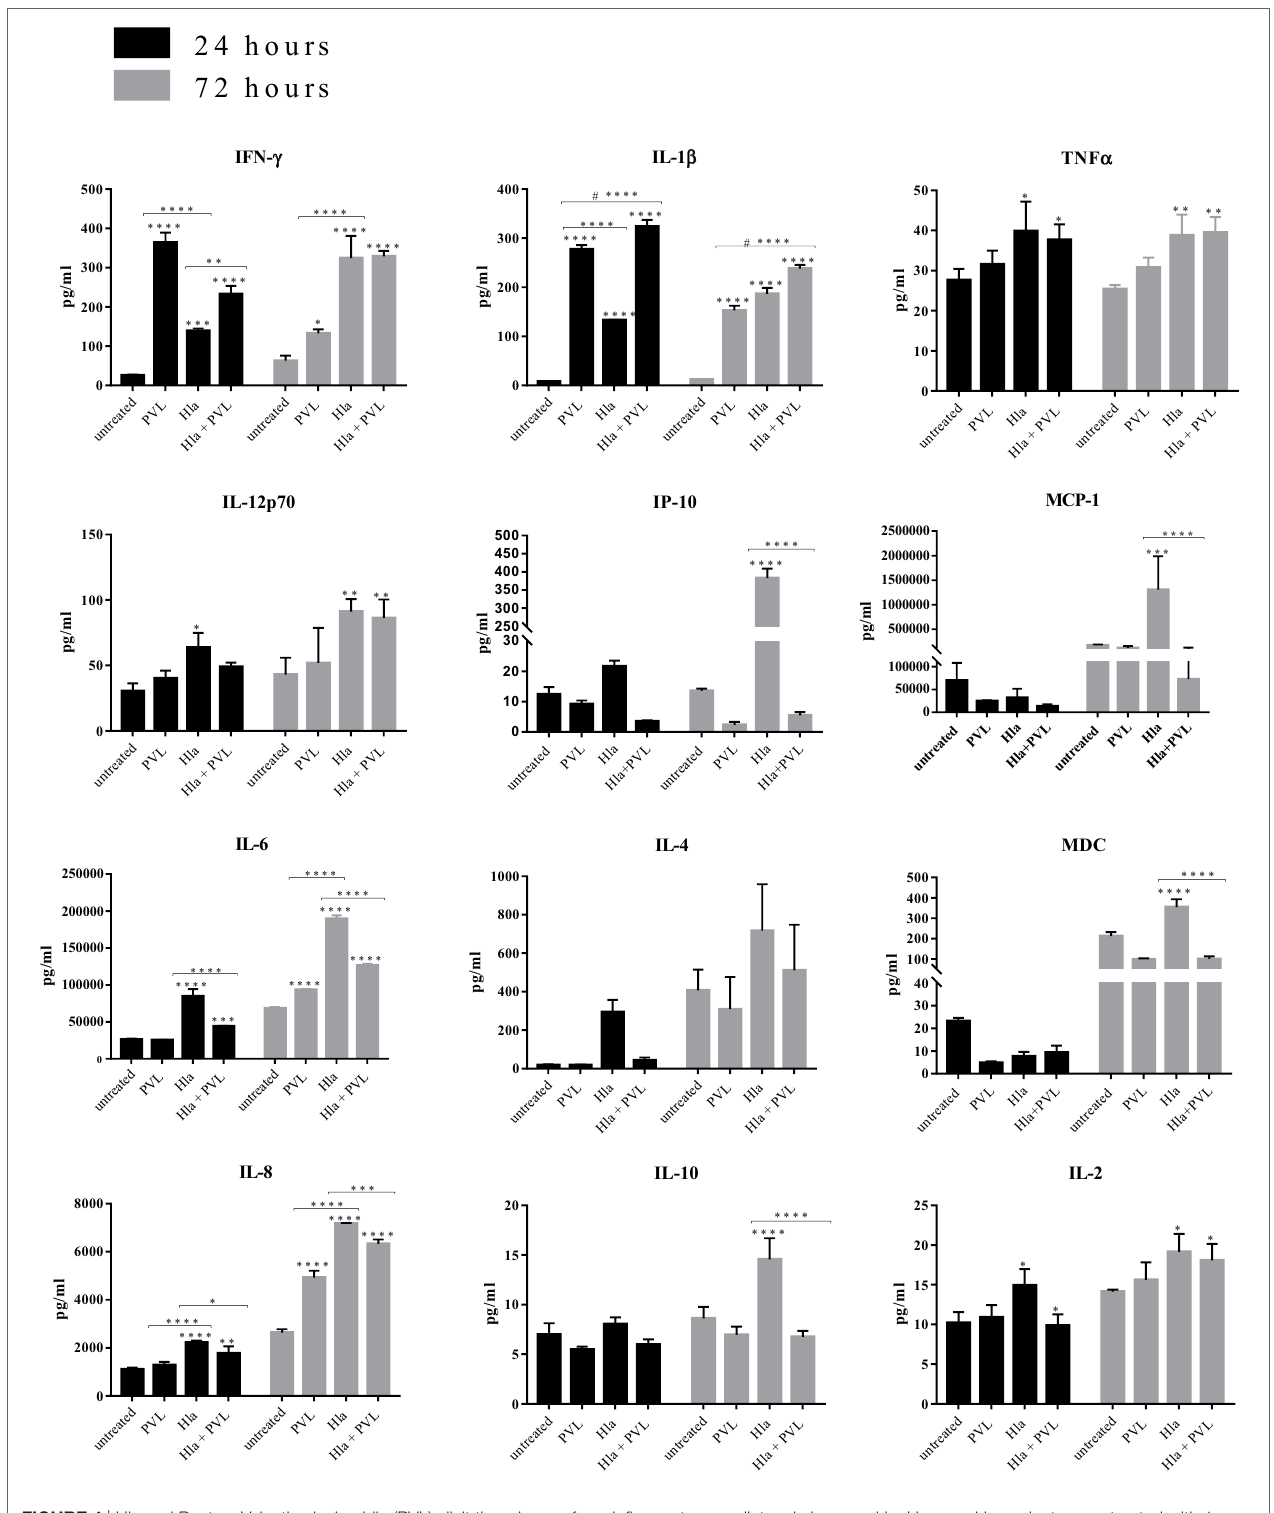
FigUre 4 | Hla and Panton–Valentine leukocidin (PVL) elicit the release of pro-inflammatory mediators in human skin. Human skin explants were treated with 1 µg of Hla, PVL, or a cocktail of both toxins at 1 µg each. Each bar represents the mean ± SD of three analyses from the skin of one donor. In addition, results were confirmed using skin explants from two additional donors in independent experiments (data not shown). Statistically significant differences were determined by two-way ANOVA, with Tukey’s multiple comparison tests, * p < 0.05, ** p ≤ 0.001, *** p ≤ 0.0002, and **** p < 0.0001. Asterisks on bars are comparisons between untreated and treated groups while lines above bars are comparisons between groups. # Represents comparisons between PVL and Hla +